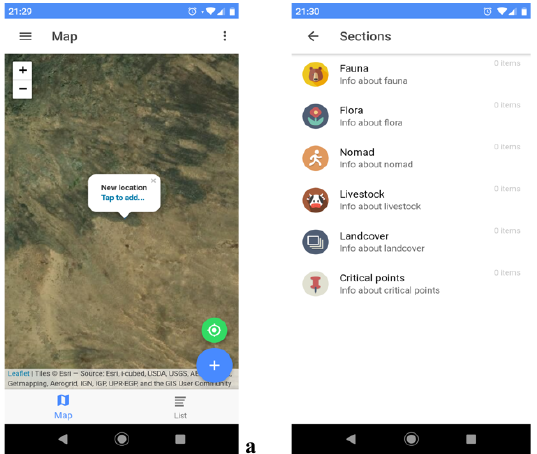
Figure 5. GBGEOApp: a) point input; b) sections.